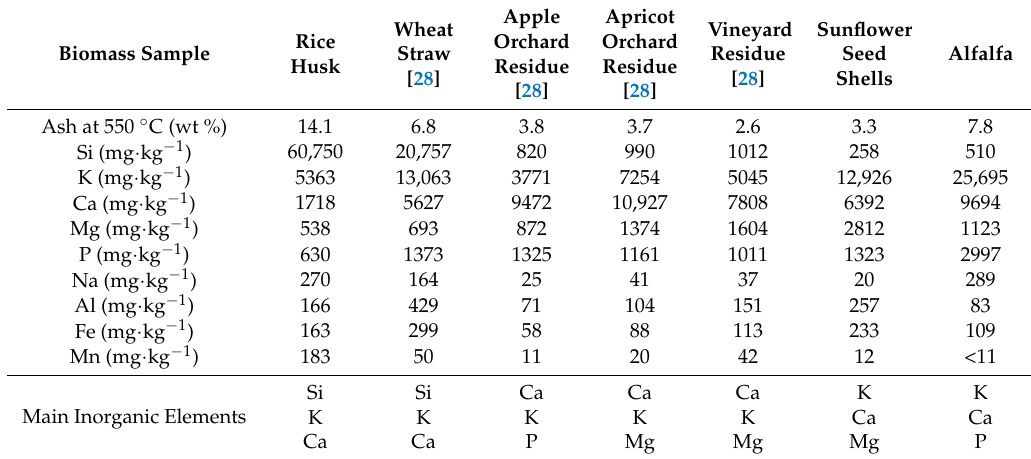
Table 1. Ash and inorganic element content of the biomass samples (on dry basis).